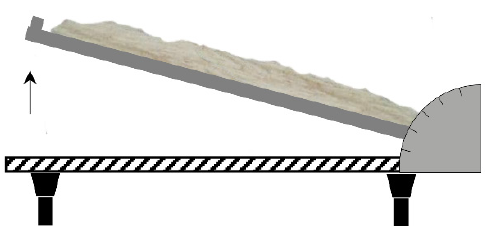
Figure 3. Scheme of the device measuring the slippery angle of repose of tested